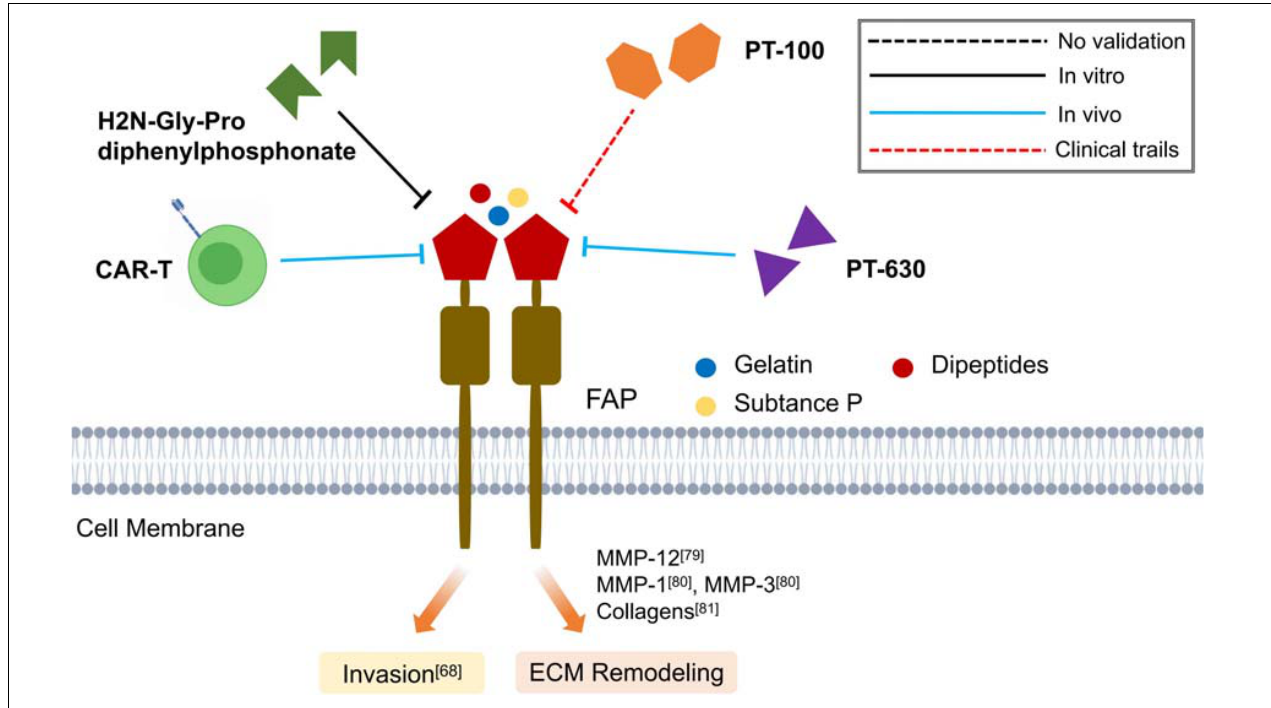
FIGURE 3 | Schematic graph showing potential antifibrotic therapies targeting FAP. (CAR-T, chimeric antigen receptors engineered T cell; MMP, matrix metalloproteinase; ECM, extracellular